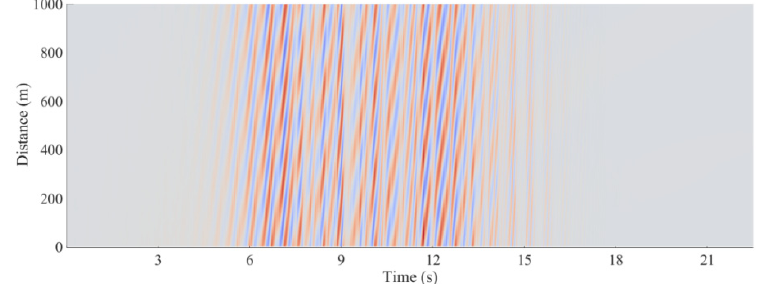
Figure 26. Evolution of the shape of ground motion field with distance.